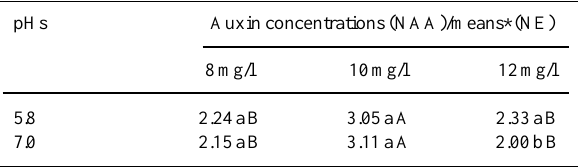
*Means followed by the same lower case letters in the column and by the same upper case letters in the line did not differ at 5% level of prob- ability by the Tukey test.